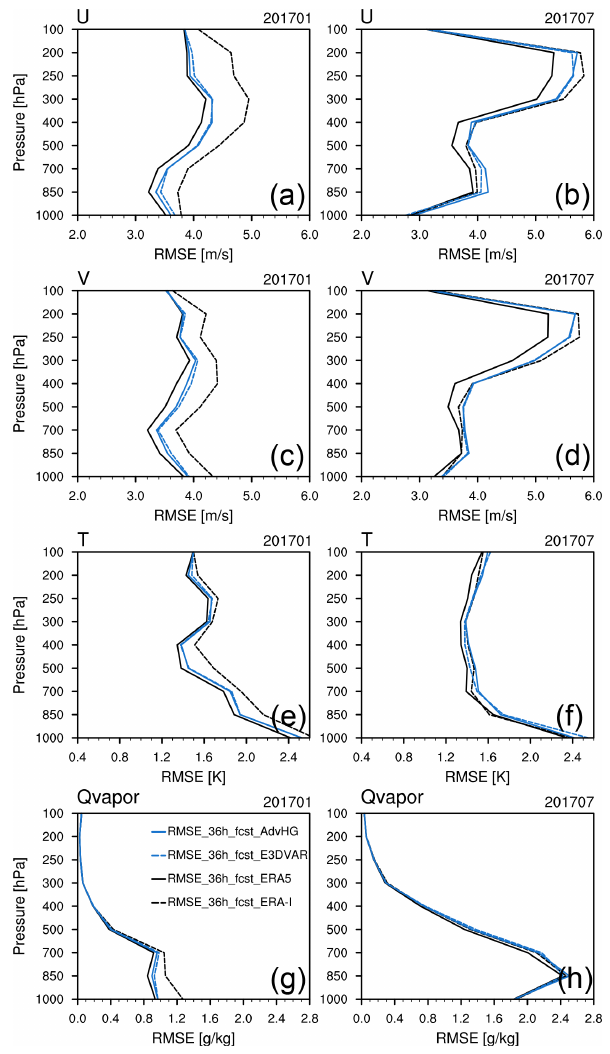
Figure 5. The same RMSEs as in Fig. 3, except for 36h forecast.